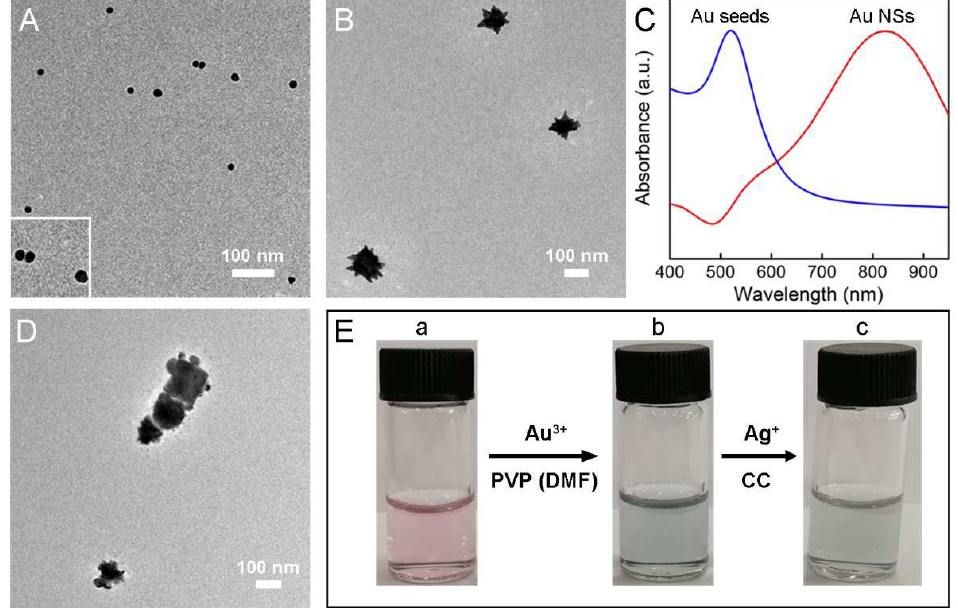
Figure 1. ( A ) TEM image of Au seeds. The insert was the partially enlarged TEM image of Au seeds. ( B ) TEM image of Au NSs. ( C ) UV-vis absorption spectra of Au seeds and Au NSs. ( D ) TEM image of 26.7 μM CC-mediated reduction of Ag + on the Au NSs. ( E ) Photographs of ( a ) Au seeds, ( b ) Au NSs, and ( c ) 5.33 μM CC-mediated reduction of Ag + on the Au NSs.